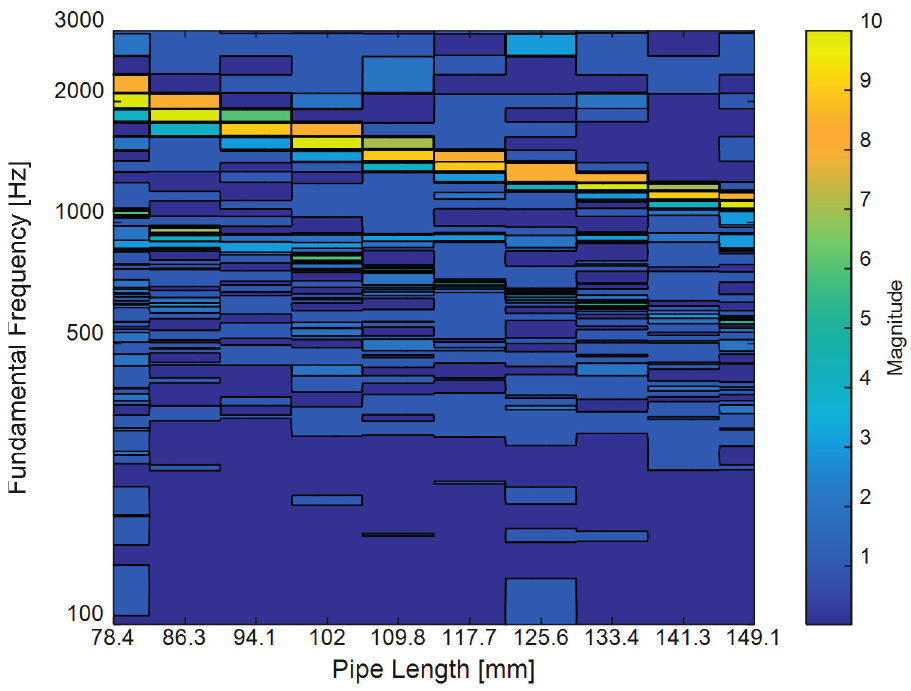
Figure 11. Simulated fundamental frequency distribution of NFML structure for various